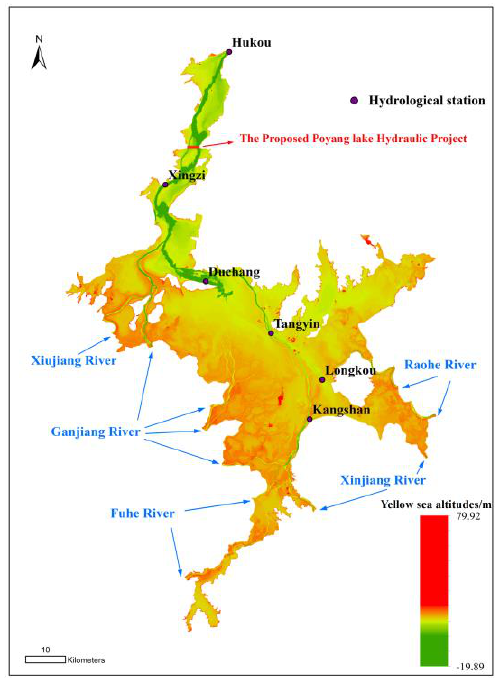
Figure 3. Topographical representation of Poyang Lake and its connected rivers. The blue arrows indicate the inflow open boundaries of the model. Hukou is the outflow open boundary. Altitude is the altitude of the Yellow Sea.